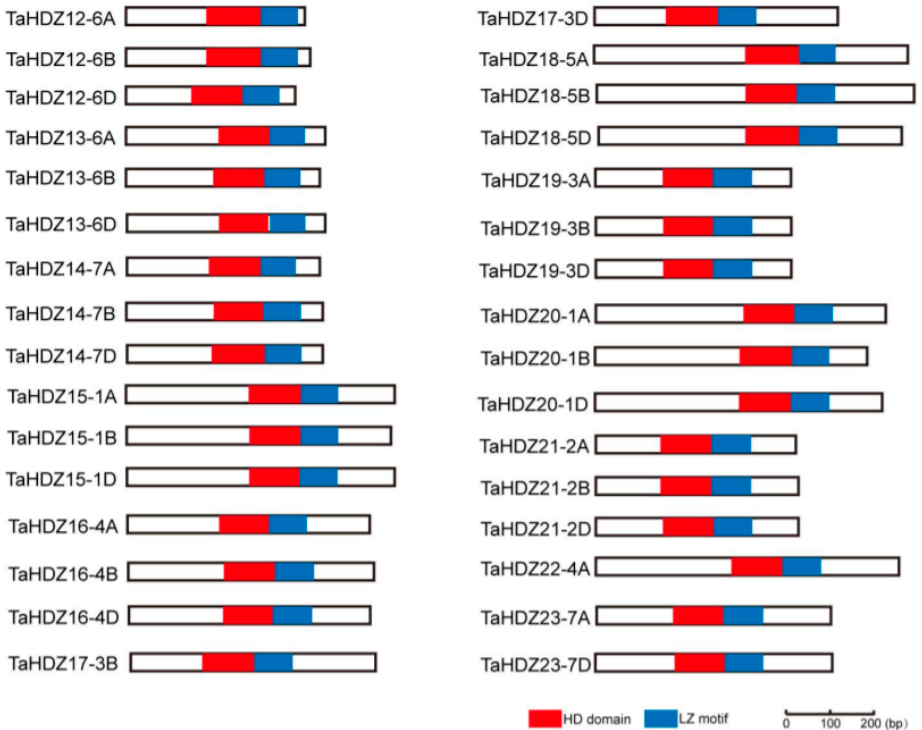
Figure 6. Schematic diagrams of the conserved domain structure of wheat HD-ZIP II subfamily proteins. Red box indicates the homeobox domain (HD) and blue box indicates the adjacent leucine zipper (LZ) motif, respectively.